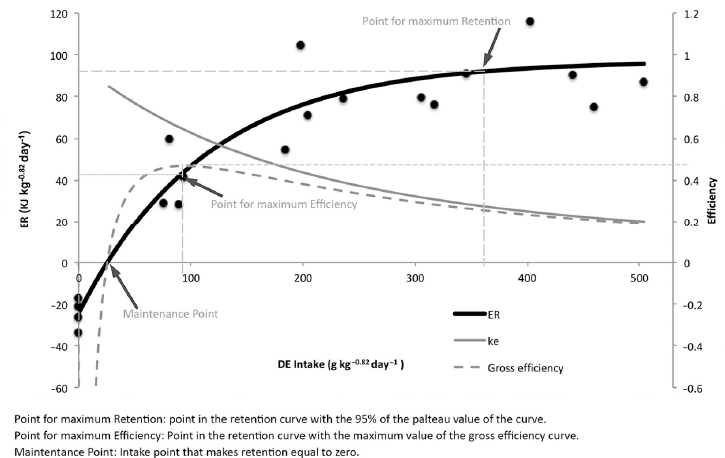
Figure 3. Effect of digestible energy intake (kJ kg − 0.82 day − 1 ) on energy retention (kJ kg − 0.82 day − 1 ). The points for maintenance, maximum efficiency, and maximum retention were de- Table 4. Protein and energy retention key termined according to the regression models (Equations (3) and (4)) and their plots (Fig- ures 2 and 3), and are presented in Tables 4 and 5 for both protein and energy retention. Net efficiency is included in Tables 4 and 5. The DP intake requirement for maintenance was obtained for protein retention 0 (y = 0), and the DP intake for the maintenance point was 0.57 g DP kg − 0.7 day − 1 . The maximum retention point was calculated at 95% of the